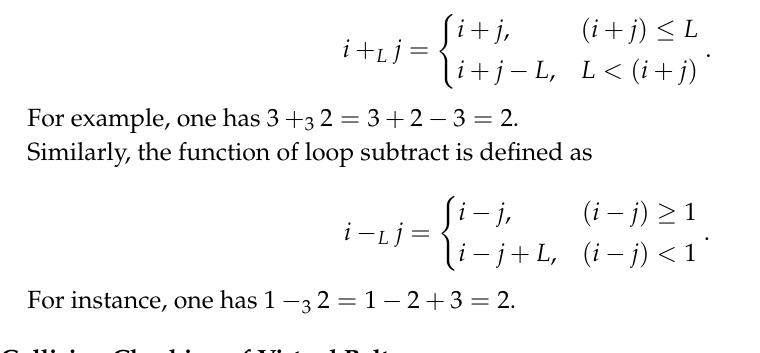
Figure 8. Motion of two VGs with collision, ( a ) t = t 0 + ∆ t , ( b ) t = t 0 + 1 t c + ∆ t , ( e ) t = t 0 + 4 ( d ) t = t 0 + 3 5